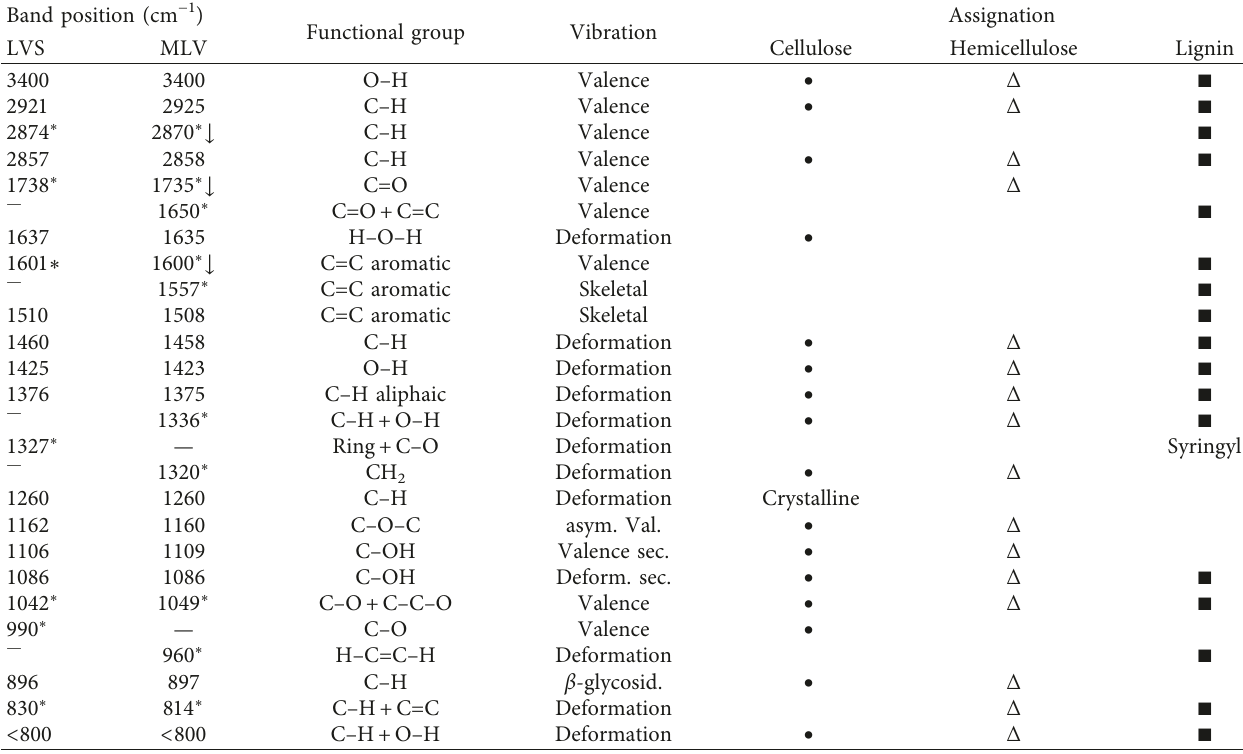
Table 5: Absorption IR bands assignation for the lignocellulosic LVS biomass and MLV precursor. Band position (cm − 1